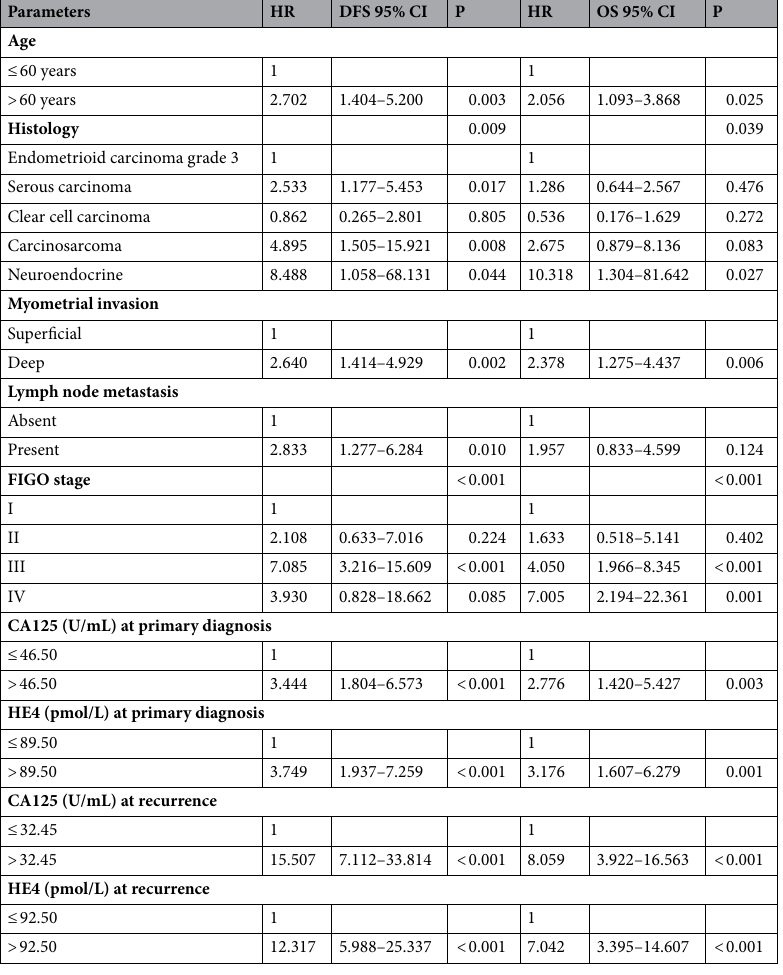
Table 4. Univariate prognostic analyses. HR hazard ratio, CI confidence